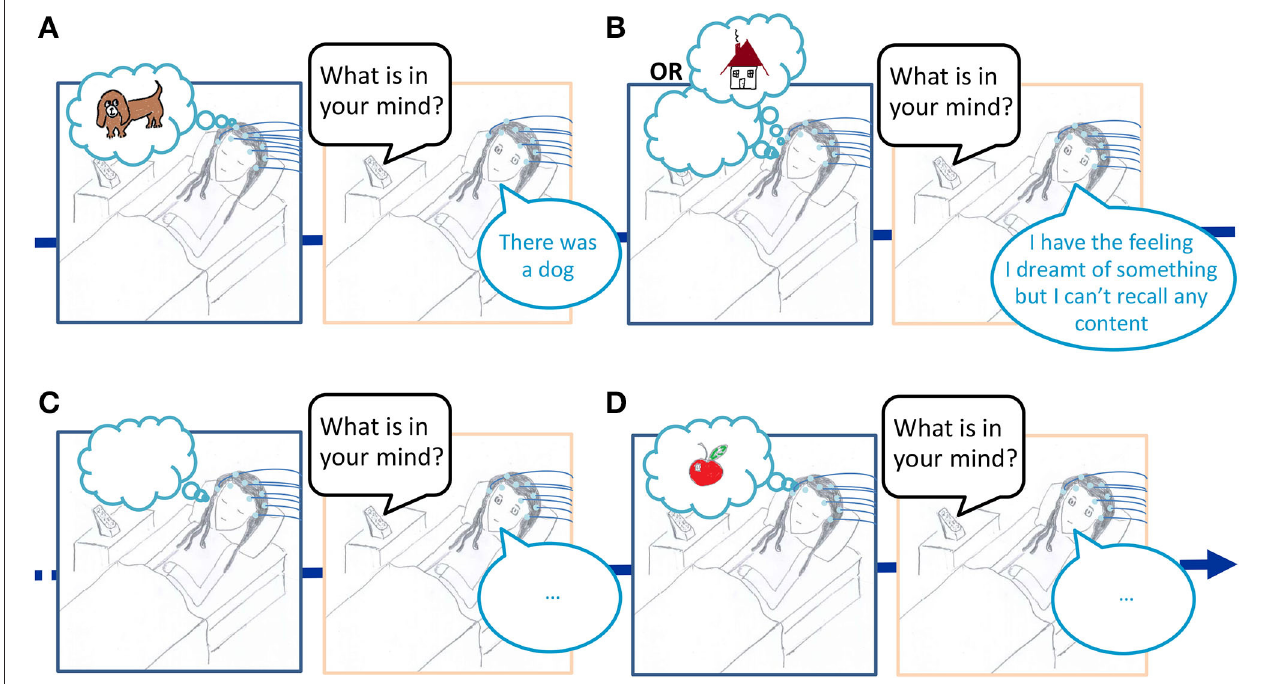
FIGURE 1 | Illustration of the serial-awakening paradigm used in the article “The neural correlates of dreaming” Nat Neurosci 2017. While a participant is sleeping in the lab with EEG electrodes on the scalp, he/she is awakened several times to report what was in his/her mind just before awakening. The EEG signal during sleep is then classified either as “preceding a dream report,” (A) “preceding a white dream report,” (B) or “preceding no dream report.” (C,D) The comparison of the EEG pattern for the sleep “preceding a dream report” vs. “preceding no dream report” is then interpreted as the neural correlates of dreaming in the article “The neural correlates of dreaming” Nat Neurosci.